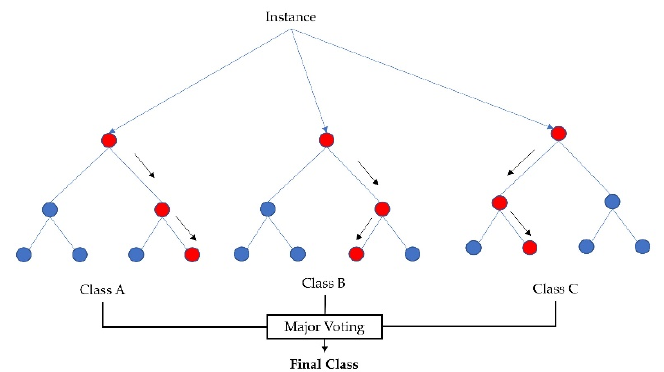
Figure 4. Random forest classifier using several decision trees and major voting for accurate classifi- cation.